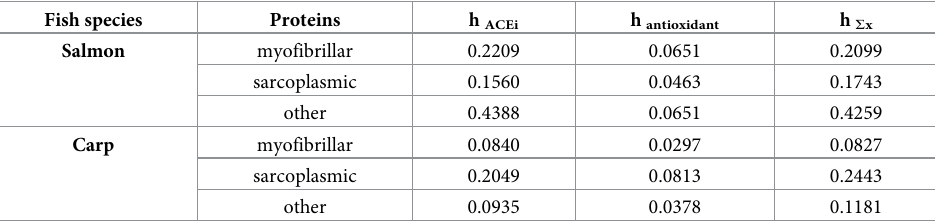
Table 2. Values of parameter h computed for selected salmon and carp